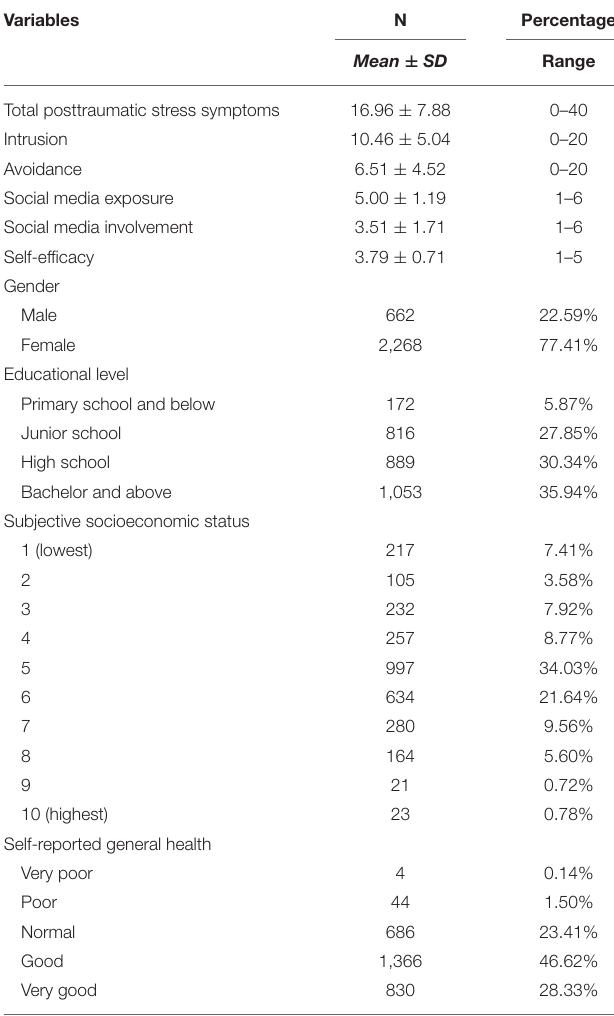
TABLE 1 | Descriptive statistics of main variables and sample characteristics ( N =